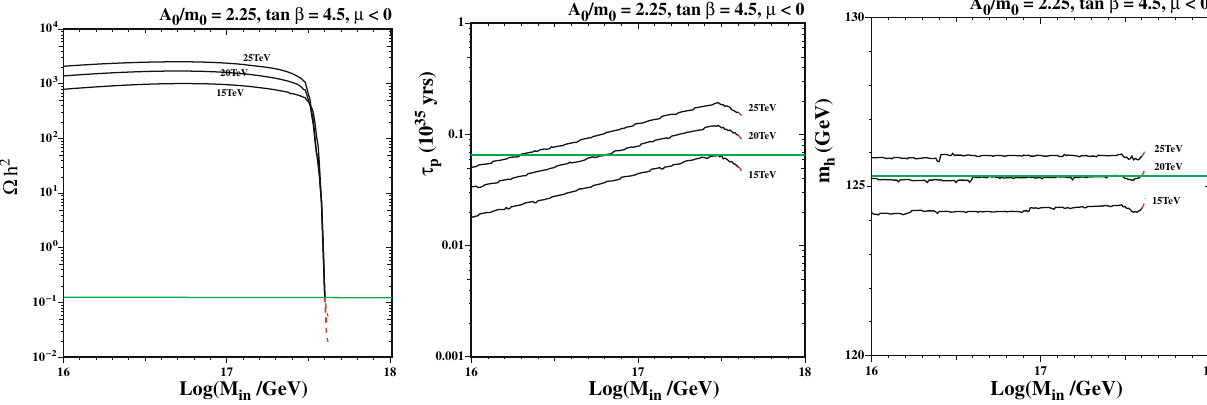
Fig. 11 As in Fig. 6, as functions of M in for the indicated fixed values of m 1 / 2 ∈ [ 15 , 25 ] TeV and m 0 chosen to obtain the cosmological value of (cid:21) = 4 × 10 17 GeV, with the same values of the other input parameters as in Fig. 2 for M LSP h in